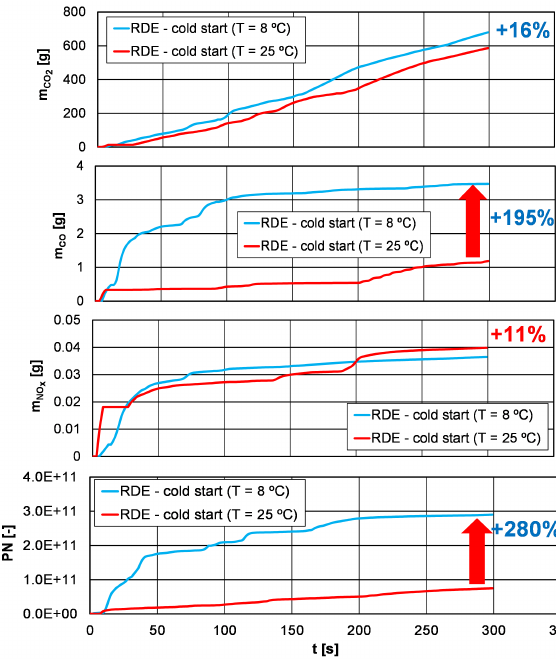
Figure 7: The mass of carbon dioxide, carbon monoxide, nitrogen oxides and particles number in first 300 s from the cold start for different values of an ambient